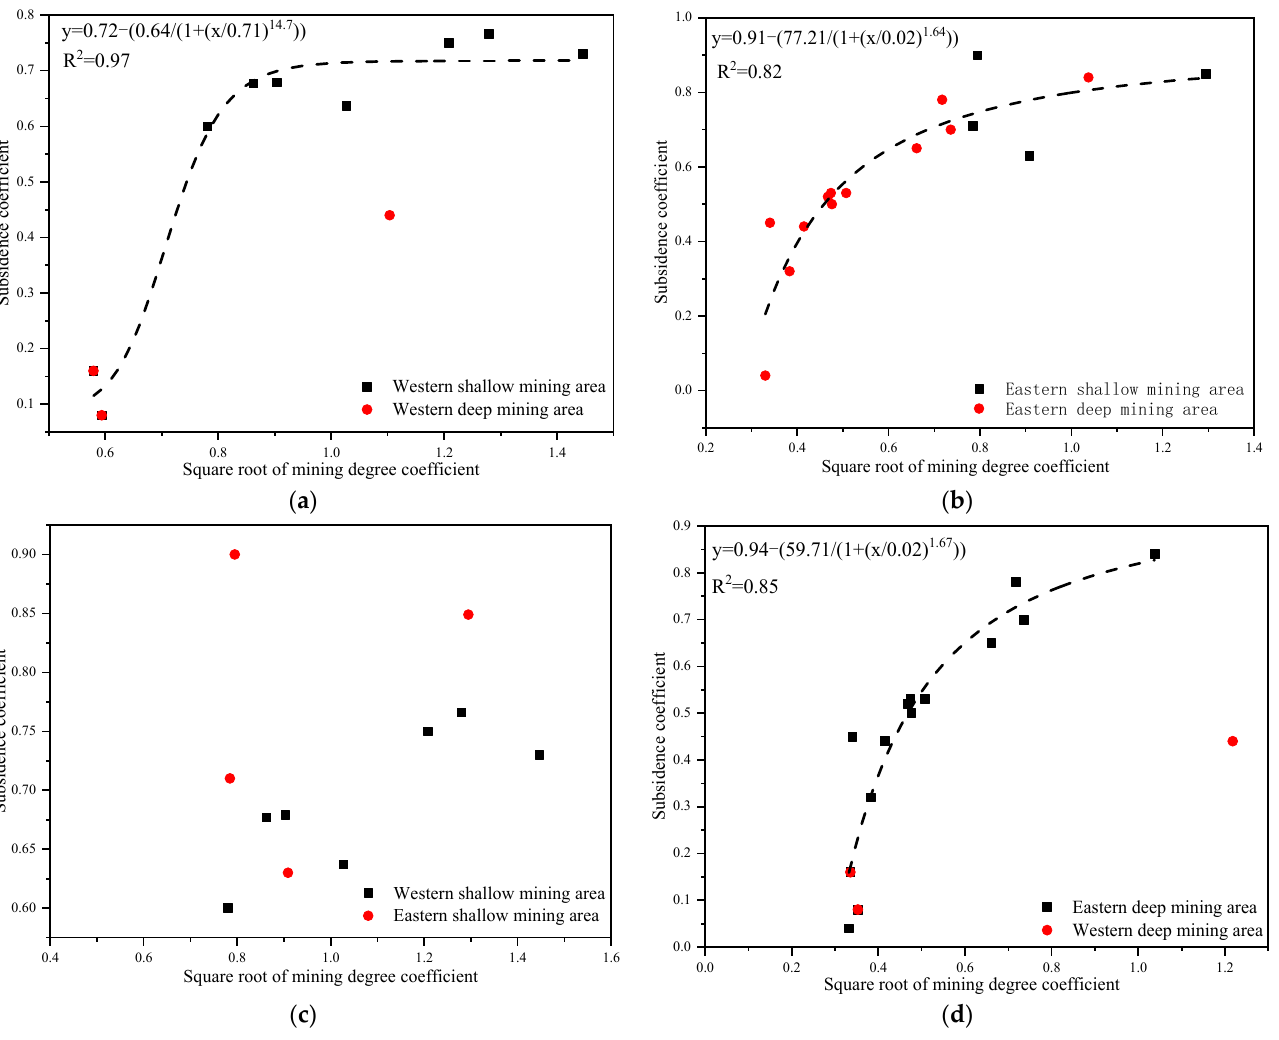
Figure 3. Scatter diagram of subsidence factors in the east and west mining areas; ( a ) scatter diagram of subsidence factors in the west regions. ( b ) Scatter diagram of subsidence factors in the middle and east region. ( c ) Scatter diagram of subsidence factors in the east and west shallow mining areas. ( d ) Scatter diagram of subsidence factors in the east and west deep mining areas.